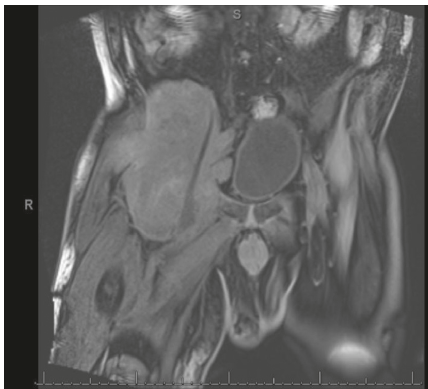
Figure 1: Large complex enhancing mass in the R iliac bone.